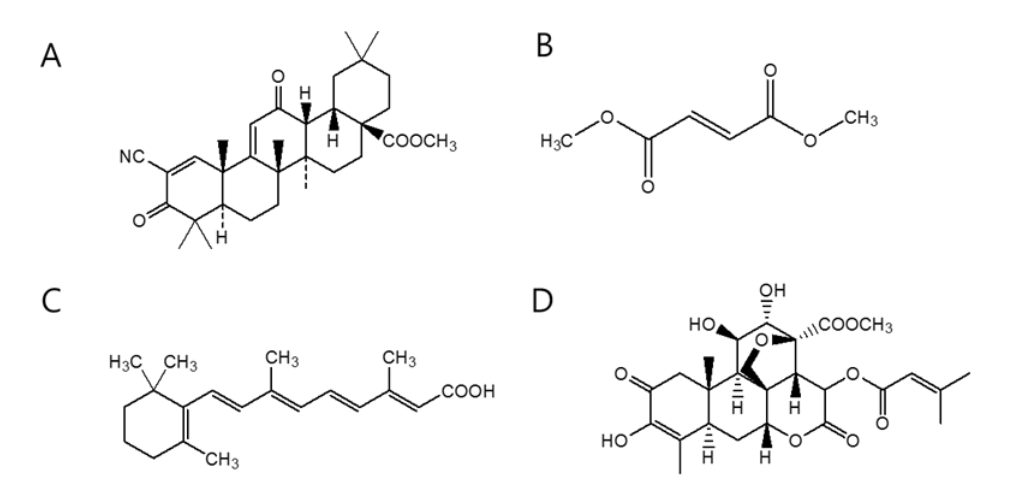
Figure 4. Chemical Structures of ( A ) CDDO-Me; ( B ) DMF; ( C ) ATRA; and ( D )